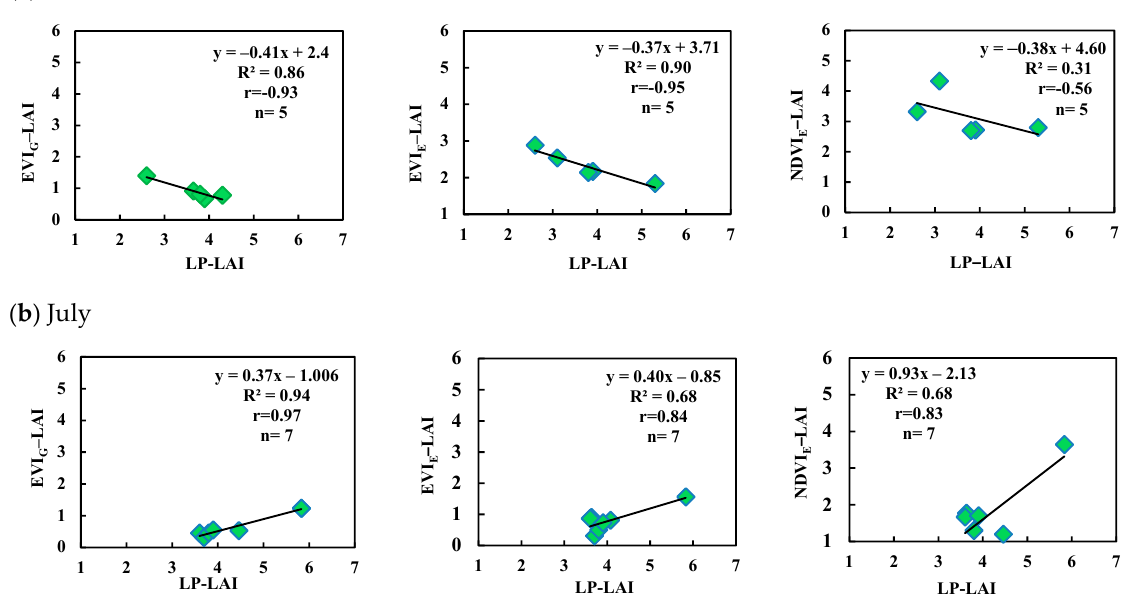
Figure 7. Scatter plots of remote sensing-based and LP 100 LAIs in ( a ) June and ( b ) July.